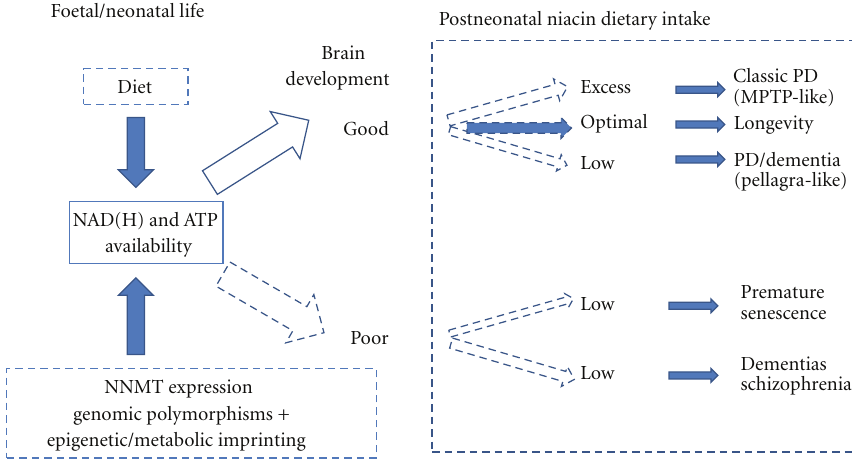
Figure 3: NAD(H) availability is key to good brain evolution and development. An inherent weak link is poor supply or a potential imbalance between induction of NNMT and nicotinamide and choline intake in early and later life with a risk of late degenerations such as Alzheimer’s and Parkinson’s disease. Overinduction of NNMT by nicotinamide could paradoxically cause intracellular pellagra perhaps explaining why nicotinamide can appear to help short-term even though nicotinamide may be a long-term toxin. In addition, poor diet or induction of NNMT disturbs the methylome and the epigenome creating cancer promoting